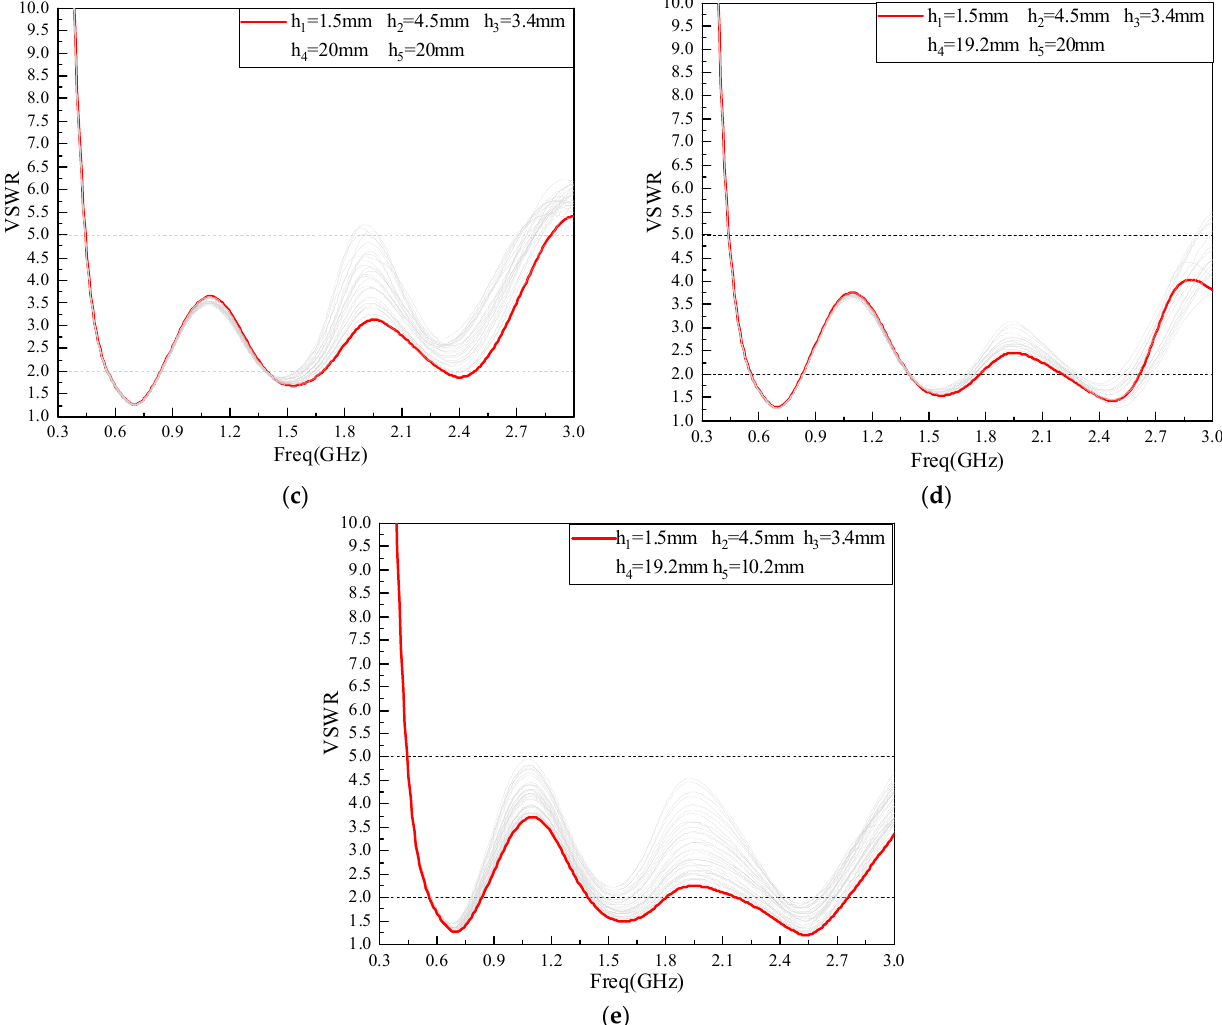
Figure 5. h 1 ~ h 5 Simulation diagram for parameter optimization: ( a ) h 1 ; (b ) h 2 ; ( c ) h 3 ; ( d ) h 4 ; ( e ) h 5 .